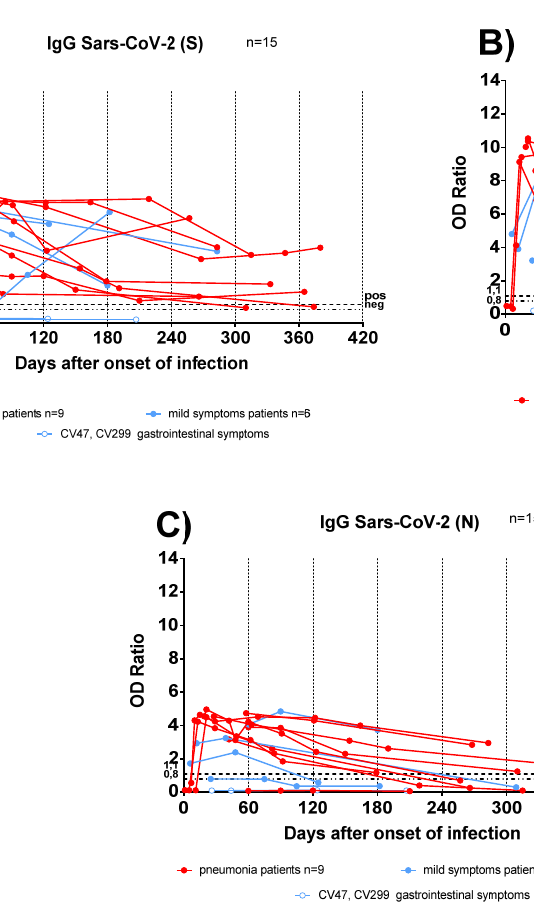
Figure 2. Antibody response kinetics in transplanted patients with pneumonia or mild symptoms. ( A ) Anti-Spike (S) IgG; ( B ) anti-Spike (S) IgA; ( C ) anti-Nucleocapsid (N) IgG. Red lines represent pneumonia patients; light blue lines represent patients with mild symptoms. Light blue lines with white circles represent patients with gastrointestinal symptoms.